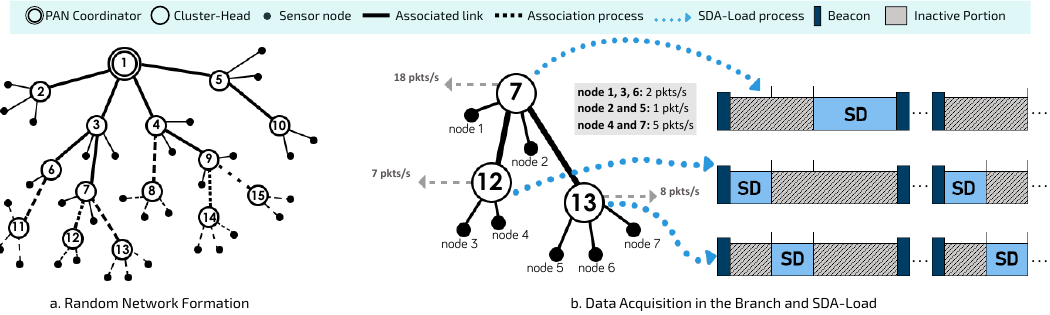
Figure 4. The cluster-tree network model: ( a ) an example of random cluster-tree formation process; ( b ) the allocation of superframe durations proportional to the data load imposed by sensor nodes (Load-SDA